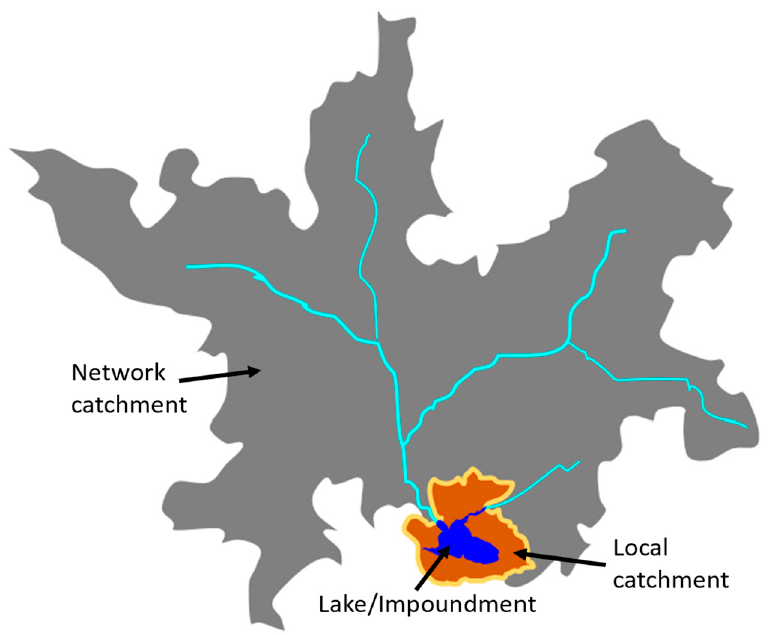
Figure 3. Lake or impoundment and its associated local and tributary catchments.